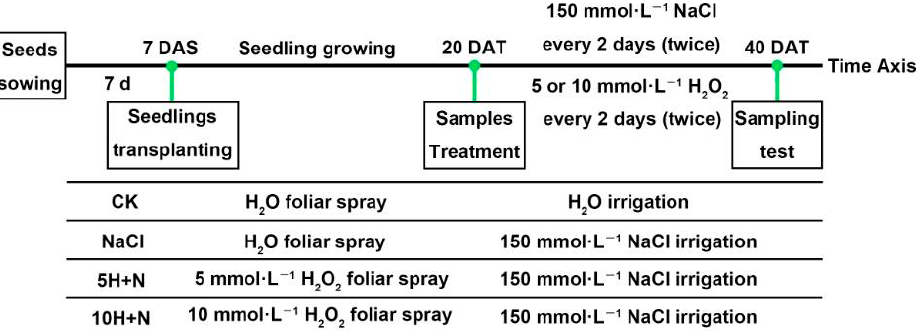
Figure 11. Schematic diagram of experimental design. 7 DAS: 7 days after sowing, 20 DAT: 20 days after transplanting. CK: control, H 2 O foliar spray + H 2 O irrigation, NaCl: H 2 O foliar spray + 150 mmol·L − 1 NaCl irrigation, 5H + N: 5 mmol·L − 1 H 2 O 2 foliar spray + 150 mmol·L − 1 NaCl irrigation, 10H spray + 150 mmol · L − 1 NaCl irrigation, 5H + N: 5 mmol · L − 1 H 2 O 2 foliar spray + 150 mmol · L − 1 NaCl + N: 10 mmol·L − 1 H 2 O 2 foliar spray + 150 mmol·L − 1 NaCl irrigation. irrigation, 10H + N: 10 mmol · L − 1 H 2 O 2 foliar spray + 150 mmol · L − 1 NaCl